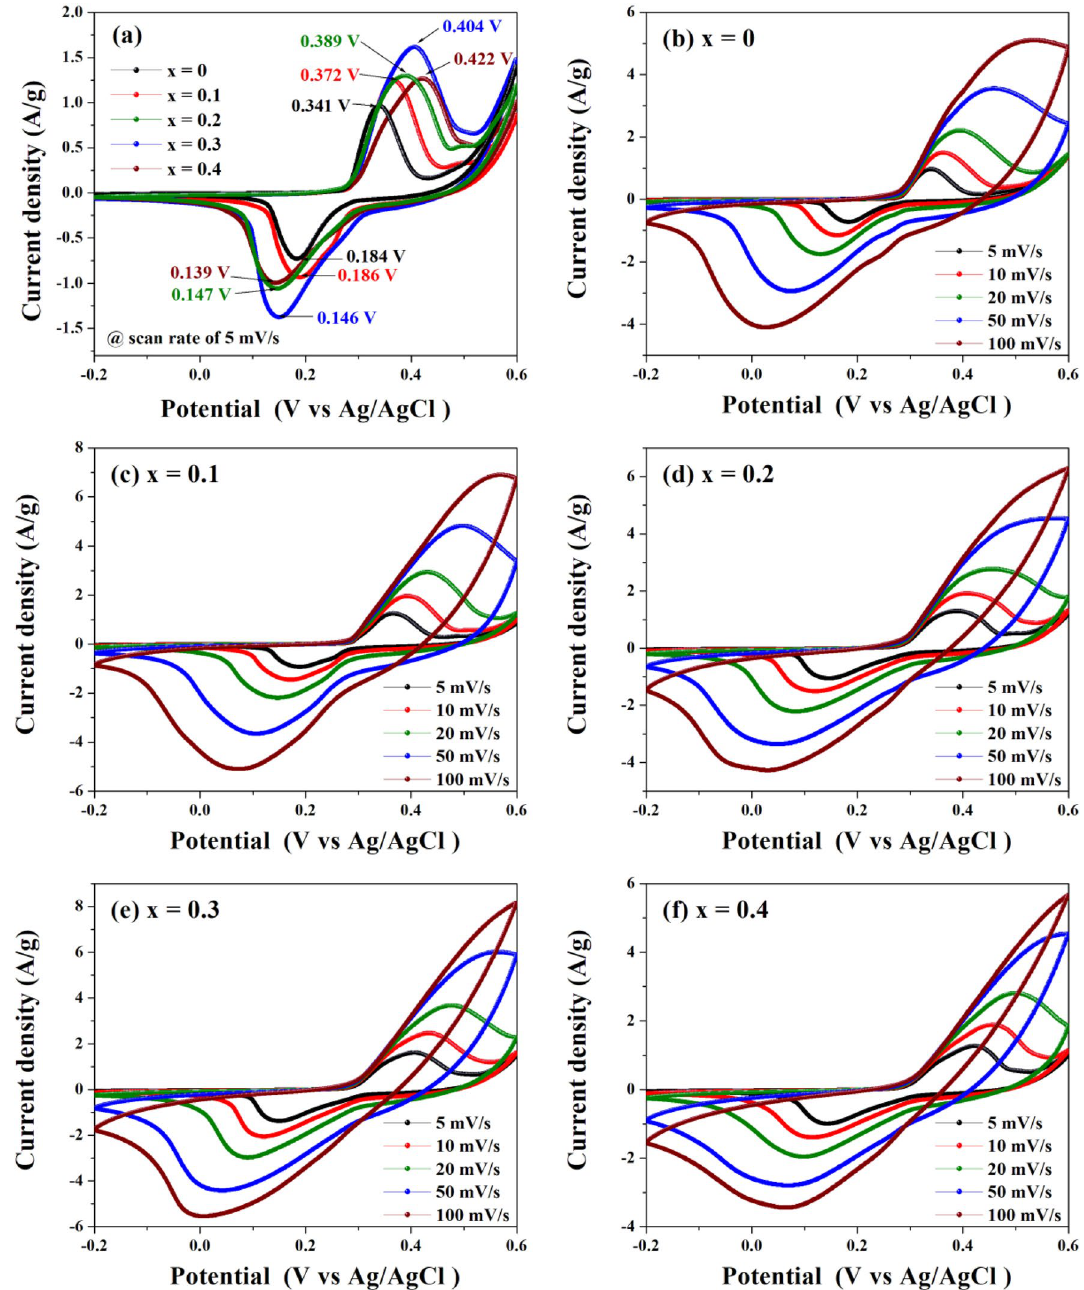
Figure 10. CV curves of Co x Zn 1−x Fe 2 O 4 (x = 0.0–0.4) NPs electrodes measured at scan rate ( a ) 5 mV/s and ( b )– ( f ) 5–100